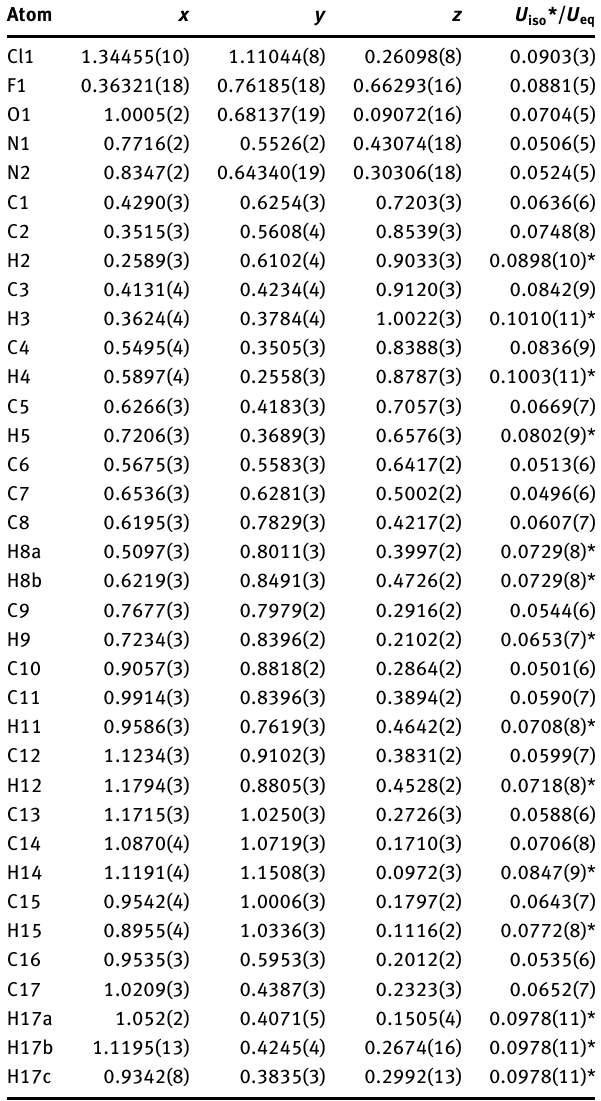
Table 2: Fractional atomic coordinates and isotropic or equivalent isotropic displacement parameters (Å 2